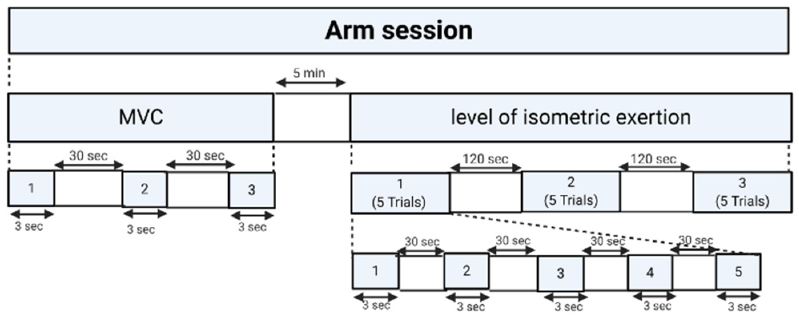
Figure 2. The study protocol for arm force exertion task. MVC: maximum voluntary contraction.